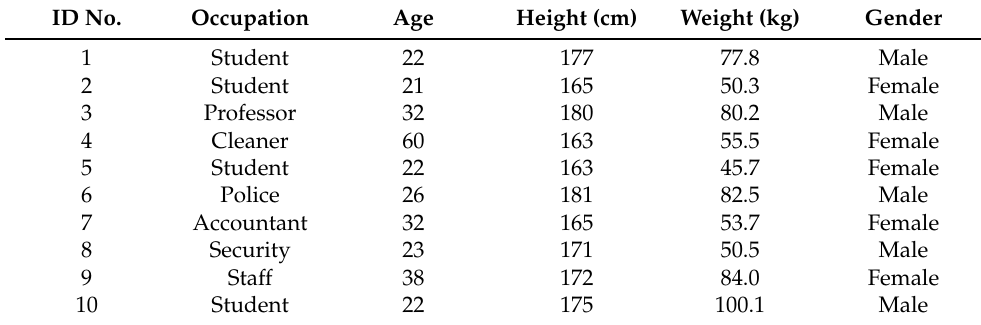
Table 2. Physical parameters of the 10 participants. ID